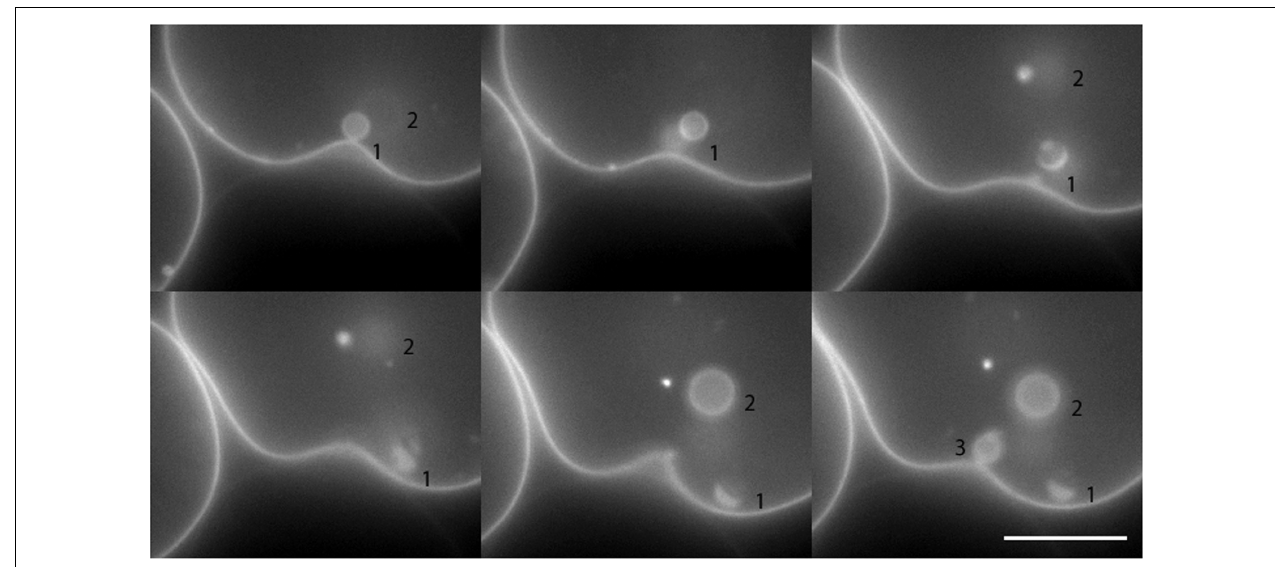
aqueous (205 μ l) bulk of a previously inflated GUV population. The formed daughter vesicles are numbered in the images series for tracking purposes. Scale bar: 10 μ m.